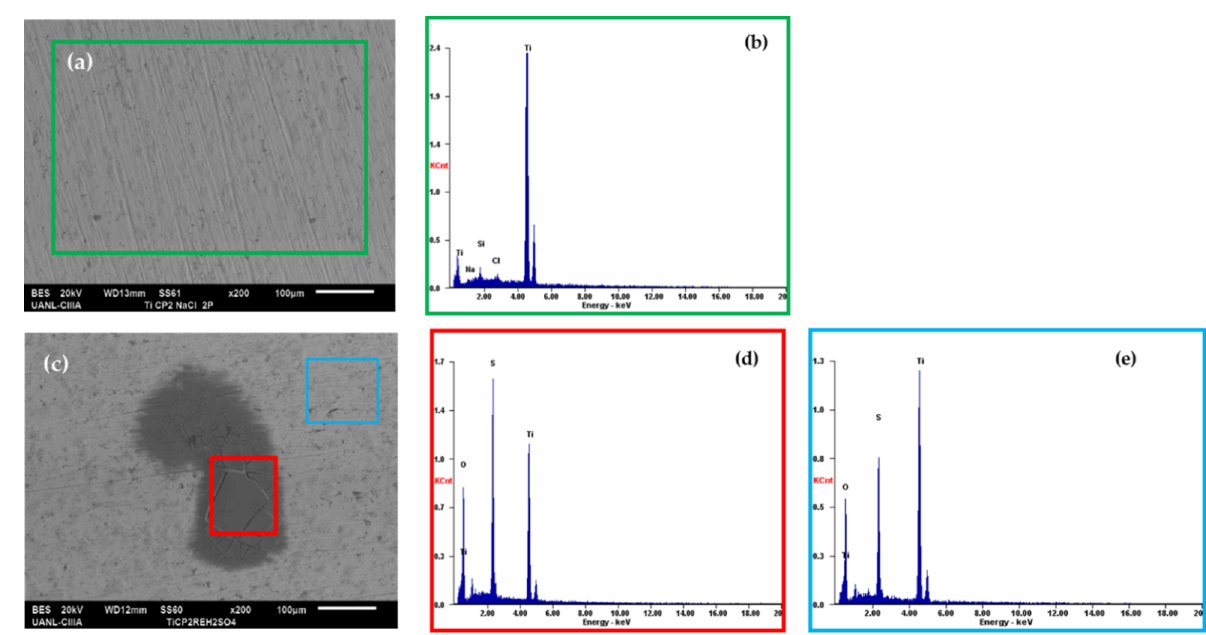
Figure 8. SEM-EDS surface morphology micrographs of Ti CP2 alloys in ( a ) NaCl and ( c ) H 2 SO 4 solution; the rectangles show the areas where EDS analysis was performed for each image; ( b ) NaCl and ( d , e ) H 2 SO 4 .